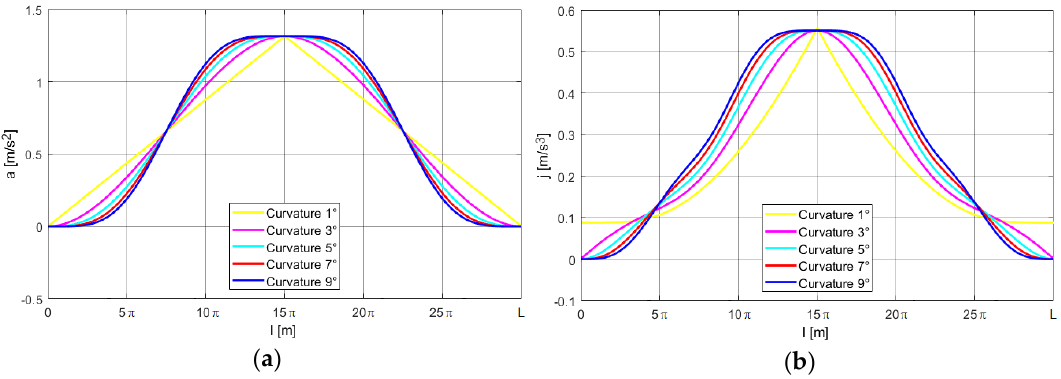
Figure 15. The course of the resultant kinematic quantities for the OMG trajectory: ( a ) accelerations; ( b ) jerks.